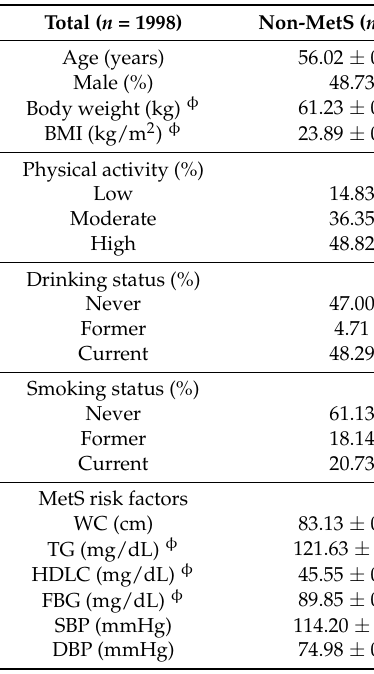
Table 1. Basic population characteristics according to MetS